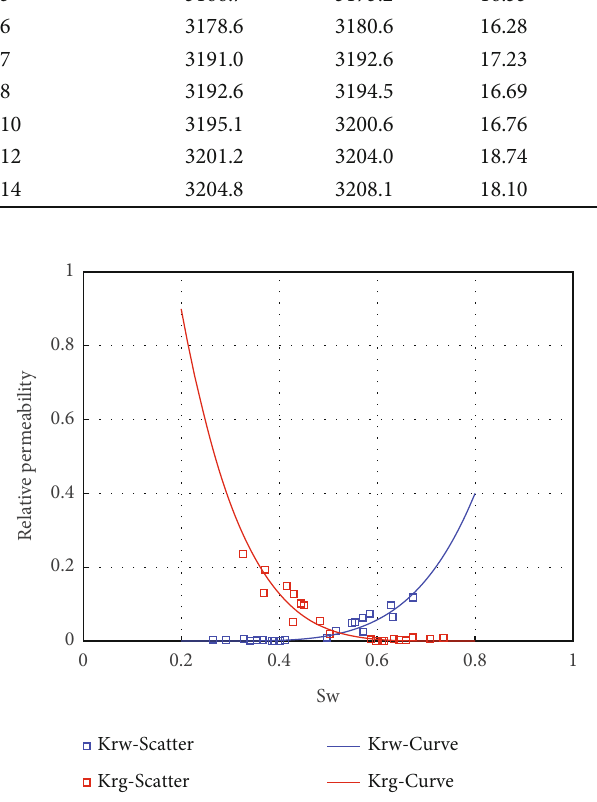
Figure 10: Characteristic scattered permeability curve